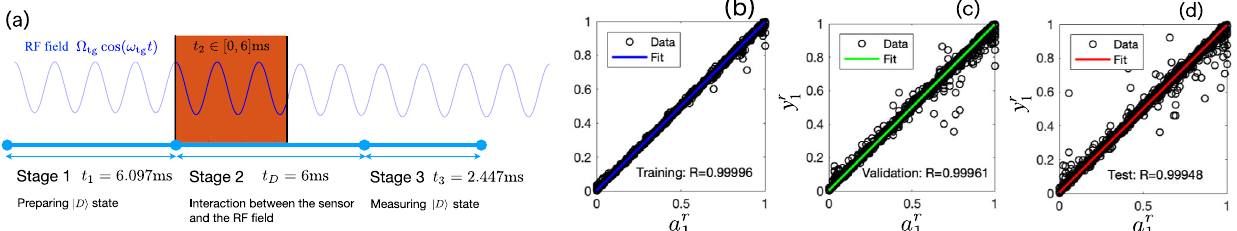
Fig. 3 Estimation results from Scenario ii, continuous data acquisition. a Schematic con fi guration of the continuous data acquisition scheme. Each binary value is obtained after completing the preparation, interaction, and measurement stages. b – d Regression of the rescaled from the NN with respect to the targets a r . The regression lines y r outputs y r ¼ Ω r ¼ α a r þ β comprise b α = 0.9946, β = 0.0032, c α = 0.9932, 1 1 1 1 tg β = 0.0040, d α = 0.9925, β = 0.0041, while the correlation coef fi cients R between the outputs and the targets are all larger than 0.999. All inputs X r , outputs Y r ¼ f y r , and targets A r ¼ f a r are rescaled into the range [0, 1 g 1 g